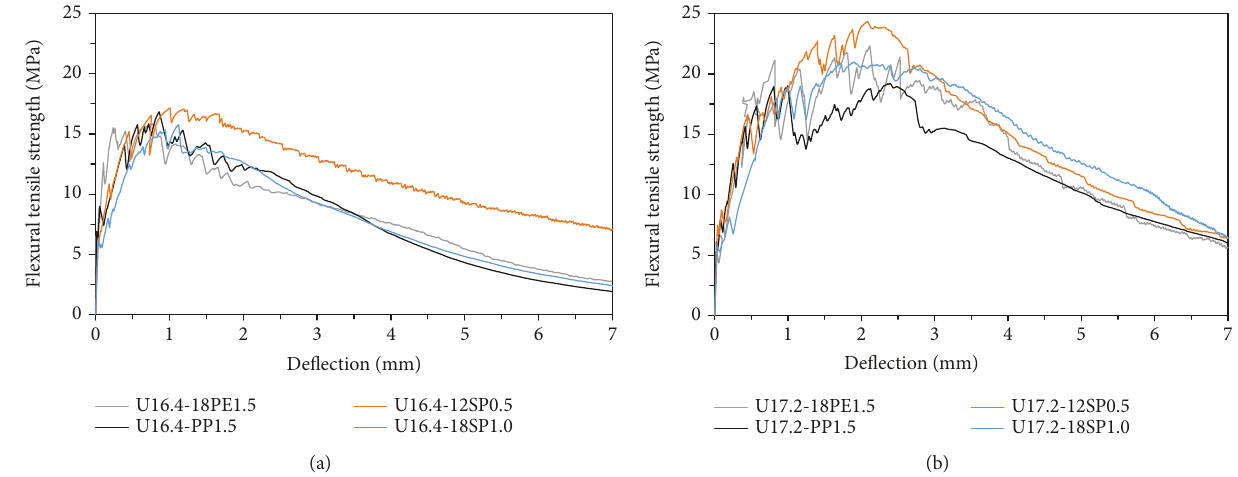
Figure 4: Flexural load-de fl ection curves: (a) w/b of 16.4% and (b) w/b of